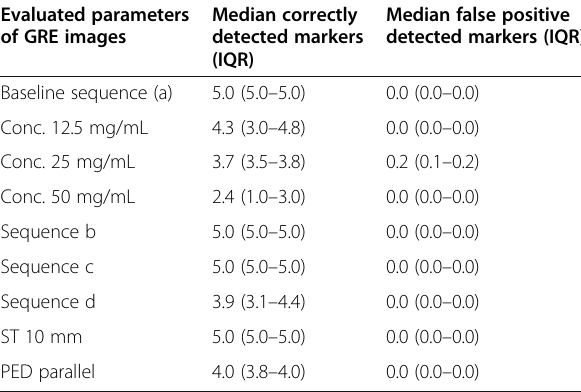
Table 3 Number of mean correctly and wrongly detected markers for each threshold per dataset Evaluated parameters of GRE